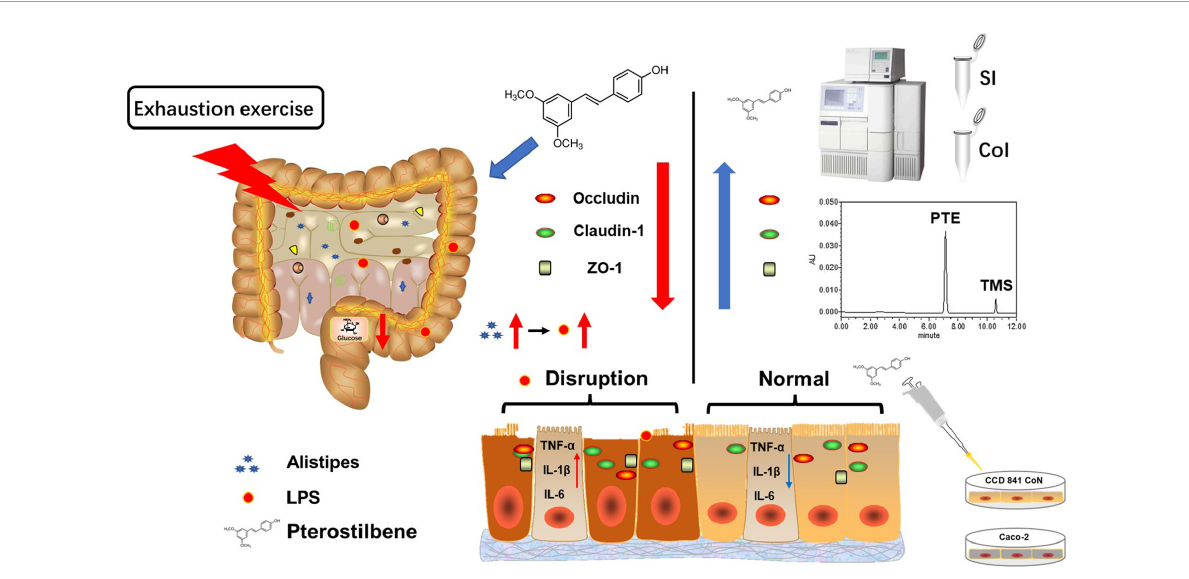
FIGURE6 Schematic summary of the results. High loading intensity of exercise disrupted the intestinal epithelial barrier through remodeling the gut flora related to LPS production. Pterostilbene attenuated exercise-induced intestinal barrier injury by improving the expression of the TJ-related genes and suppressing